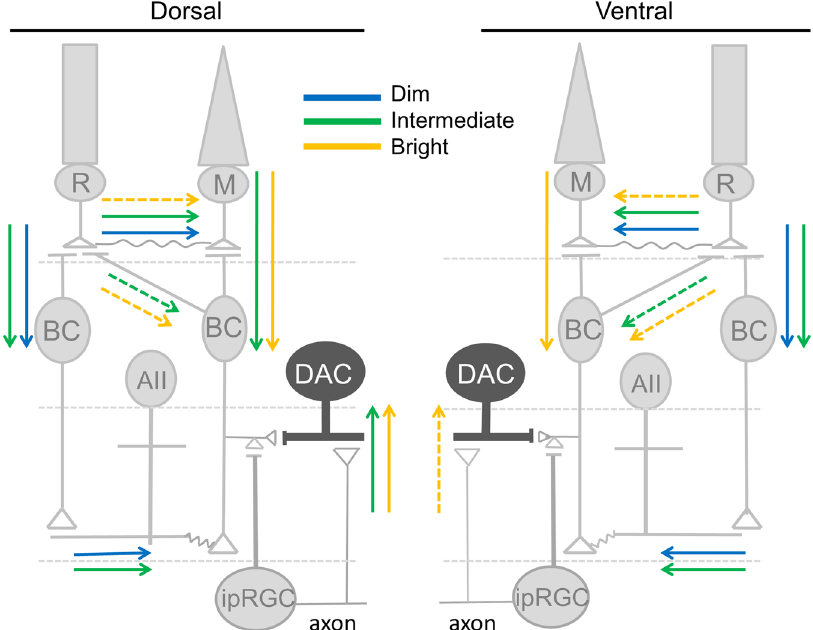
Figure 8. Proposed inputs from three distinct photoreceptor classes to DACs under different lighting conditions. The dorsal retinal network is illustrated on the left side; the ventral retinal network is depicted on the right side. R: rod; M: M-cone; BC: bipolar cell; AII: AII amacrine cell; DAC: dopaminergic amacrine cell; ipRGC: intrinsically photosensitive retinal ganglion cell. Under dim lighting conditions, DACs in the ventral and dorsal retina receive equal input from rods through the primary (rod ─ > rod BC ─ > AII amacrine ─ > cone BC) and secondary (rod ─ > cone) rod pathways (blue arrows) and possibly from the tertiary rod pathway (rod ─ > cone BC) (dashed blue line/arrow). Under intermediate lighting conditions, DACs in both the ventral and dorsal retina receive input from rods (green arrows). DACs in the dorsal retina also receive input from cones and melanopsin (green arrows). Under bright lighting conditions, DACs in the dorsal and ventral retina receive cone input (orange arrows). Additionally, DACs in the dorsal retina receive melanopsin input (orange arrow); melanopsin may contribute to DAC signalling in the ventral retina as well (dashed orange line/ arrow). Under bright lighting conditions, rods may also excite DACs through the secondary and tertiary rod pathways (dashed orange